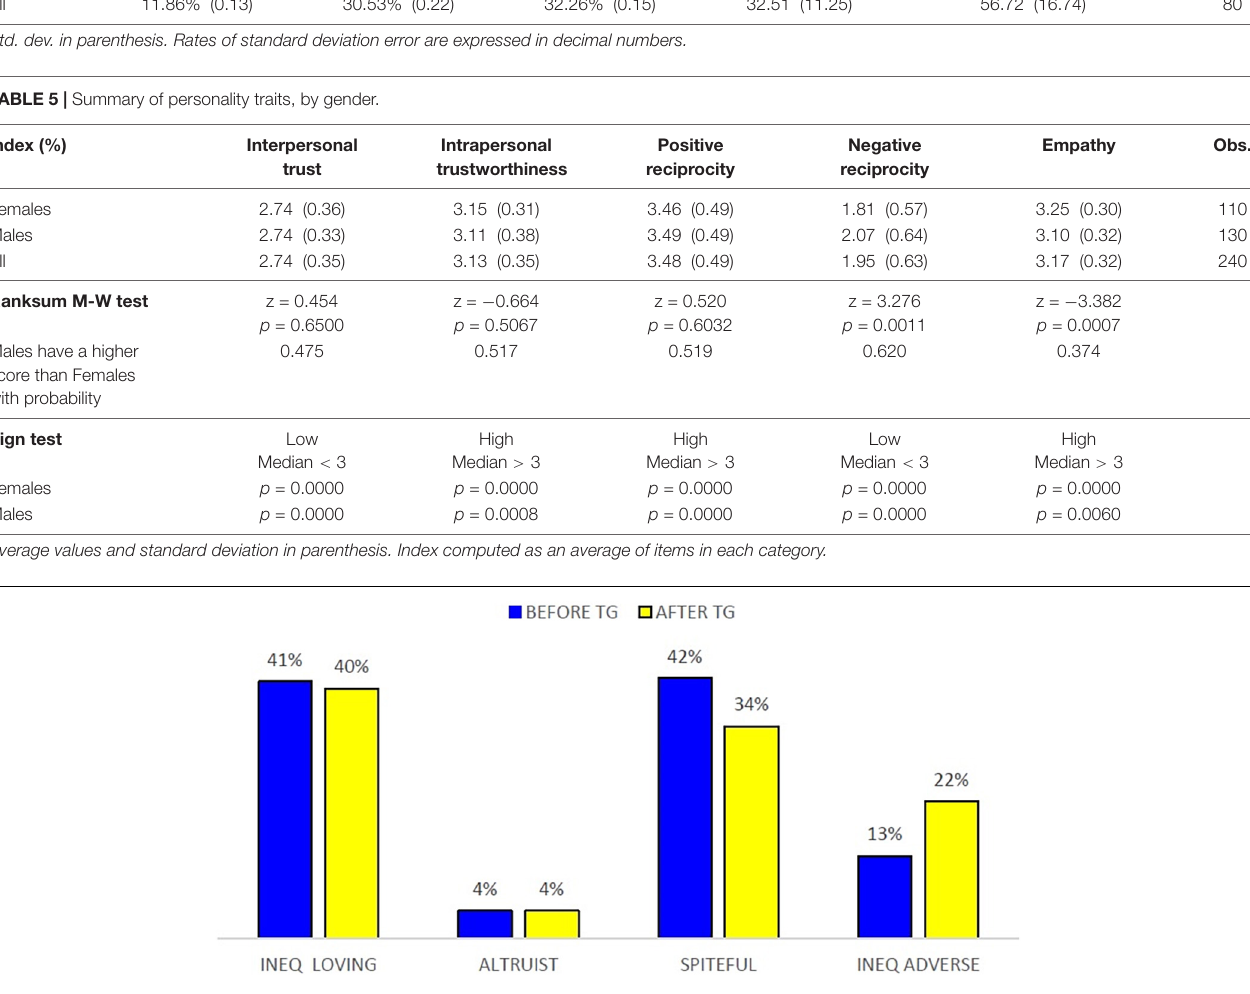
FIGURE 2 | Frequency of EET archetypes before and after playing the